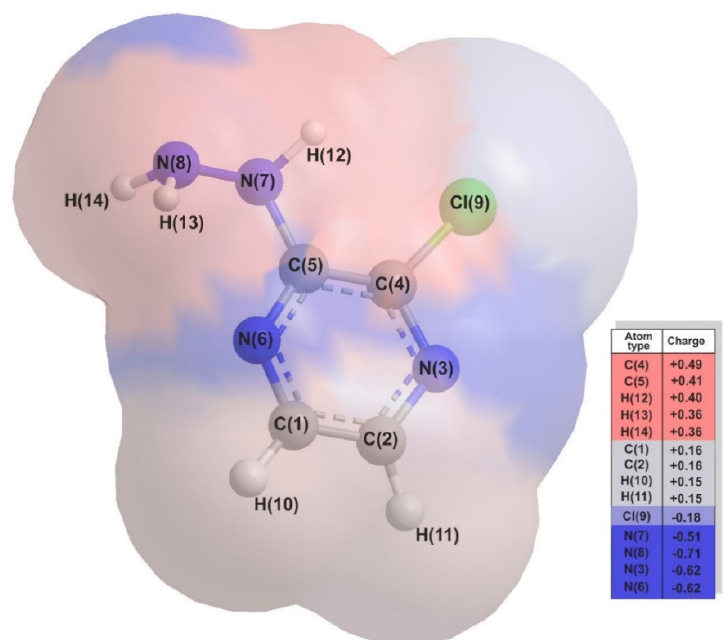
Figure 2. The structure of the 2 − chloro − 3 − hydrazinopyrazine (2Cl3HP) together with the spatial map of the electron density distribution (Mulliken charges) received in the Chem3D ® program by Perkin Elmer .